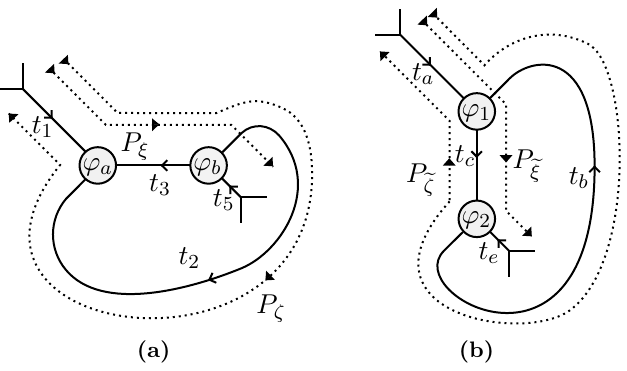
Figure 18. Two dual subgraphs with a pair of opposite edges joined to form a